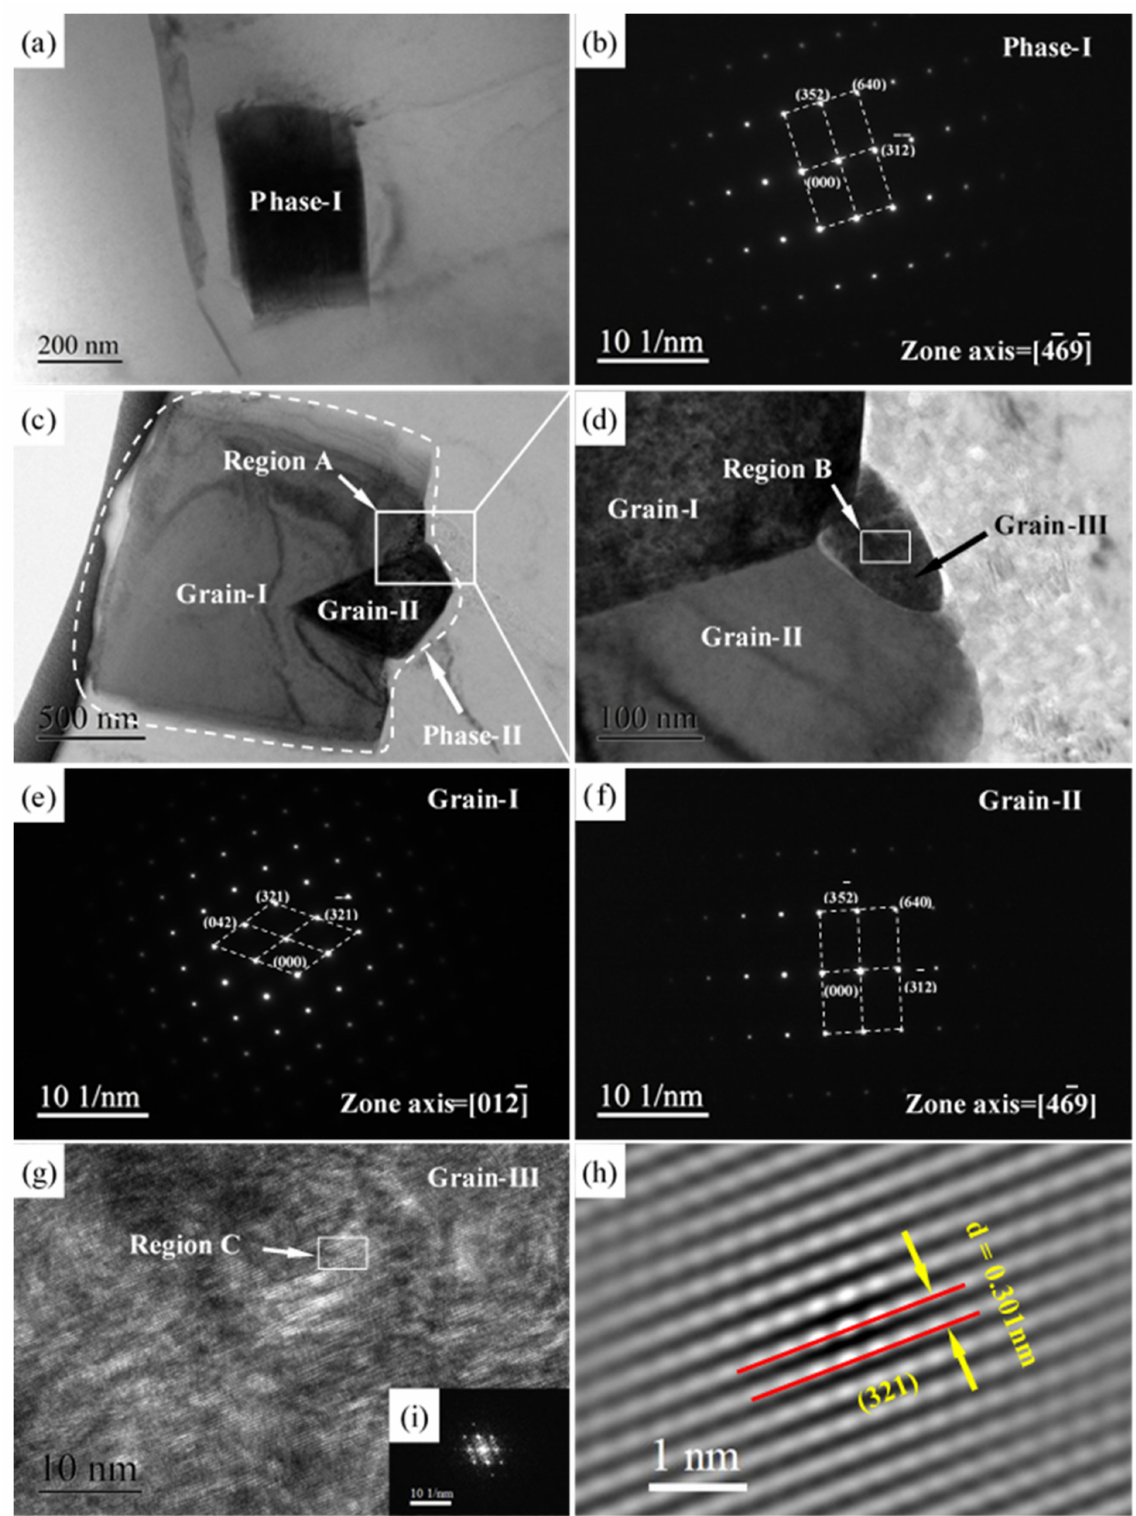
Figure 9. Bright field TEM micrographs of ( a ) phase-I, ( c ) phase-II, and ( d ) local magnification corresponding to region A; SAED patterns of ( b ) phase-I, ( e ) grain-I, and ( f ) grain-II; ( g ) HRTEM micrograph of region B in grain-III; ( i ) FFT pattern; and ( h ) inverse FFT micrograph of region